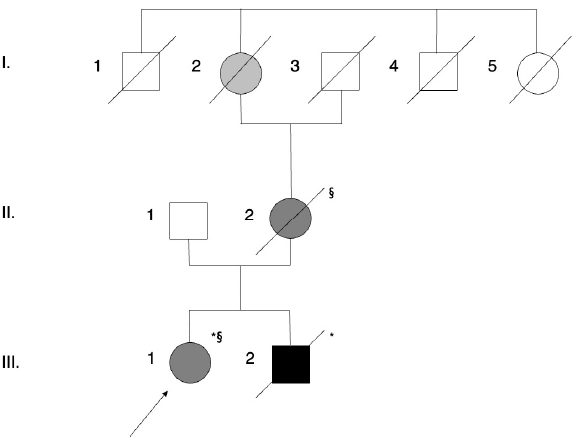
Figure 2. Pedigree of the family: the filled symbols indicate the affected individuals, with black indicating Amyotrophic Lateral Sclerosis, dark grey indicating Dementia, and light grey indicating Parkinson’s Disease. Roman numerals (I, II, III) indicate the generation within the pedigree. Available DNA samples are indicated by asterisks (*); available CSF samples are marked with §; proband (III-1) is marked with an arrow.